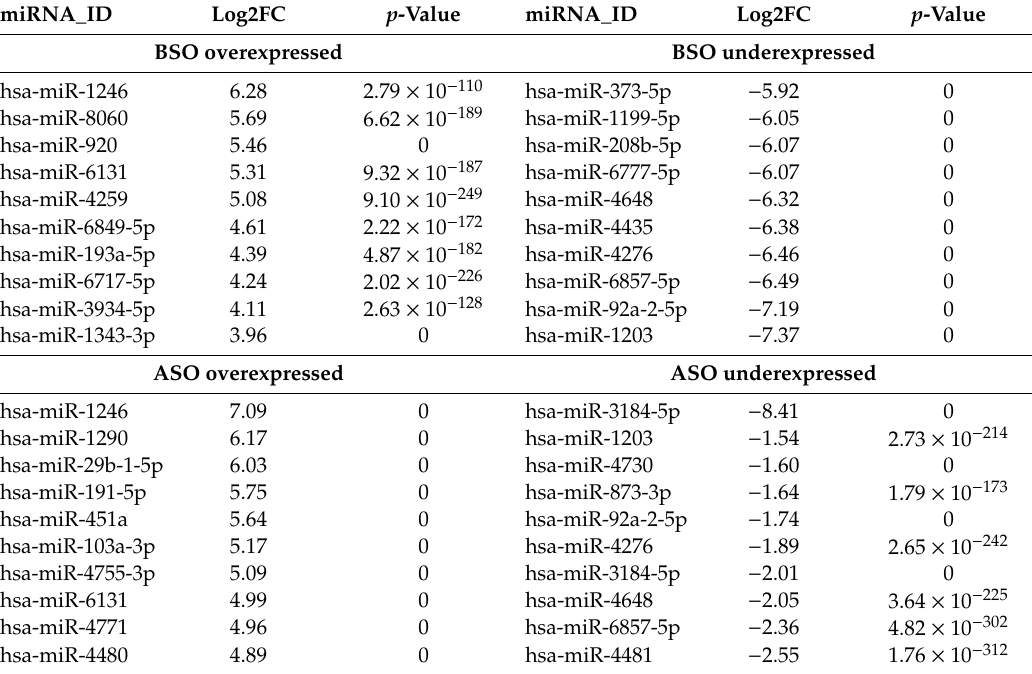
Table 1. Top 10 overexpressed and underexpressed circulating miRNAs (cmiRNAs).